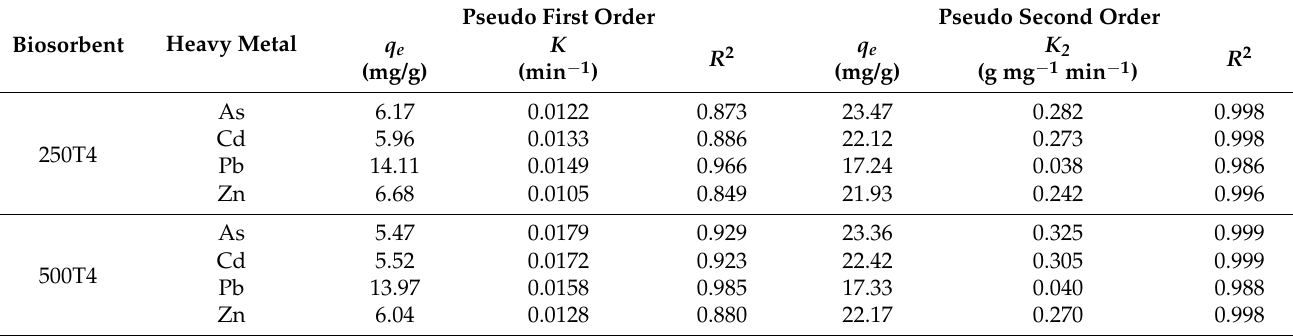
Table 5. Parameters of the adsorption kinetic models for the biosorbent T4 (250 and 500 µ m